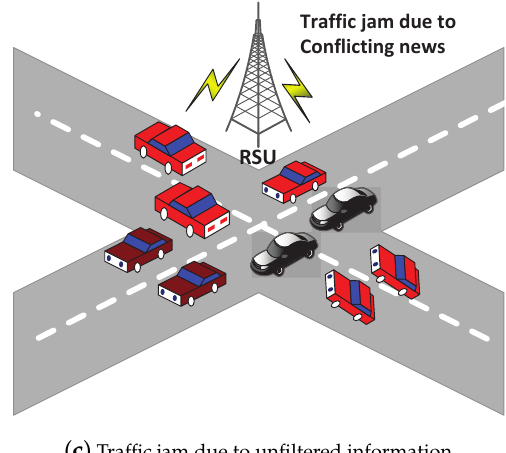
Figure 1. Traffic monitoring results in VIoT ( a ) Result of trust information which makes vehicles divert timely. ( b ) Conflicting news from two vehicles. ( c ) Result of unfiltered information from untrusted